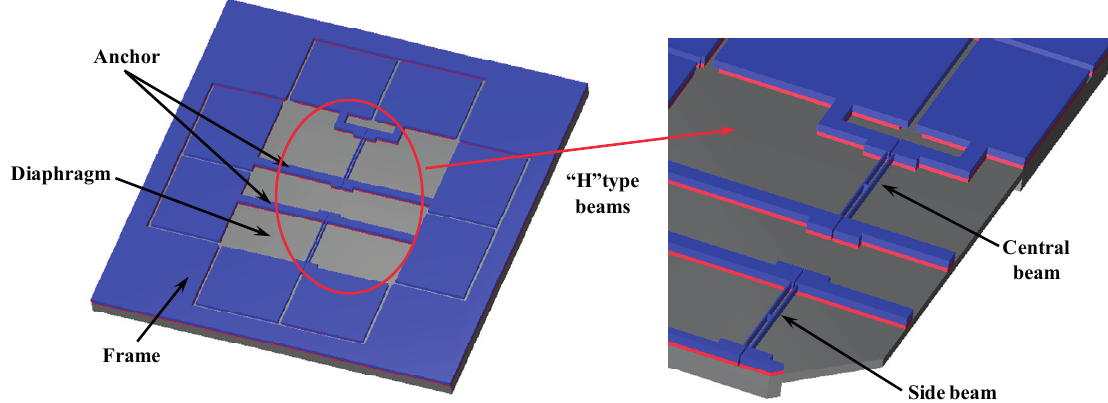
Figure 1. The schematic diagram of the differential pressure sensor includes a square pressure-sensitive diaphragm and two “H” type doubly-clamped resonant beams. The pressure under measurement causes a deflection of the diaphragm, which is translated to an axial tensile stress in the central beam and an axial compressive stress in the side beam, leading to resonant frequency shifts towards opposite directions as a differential